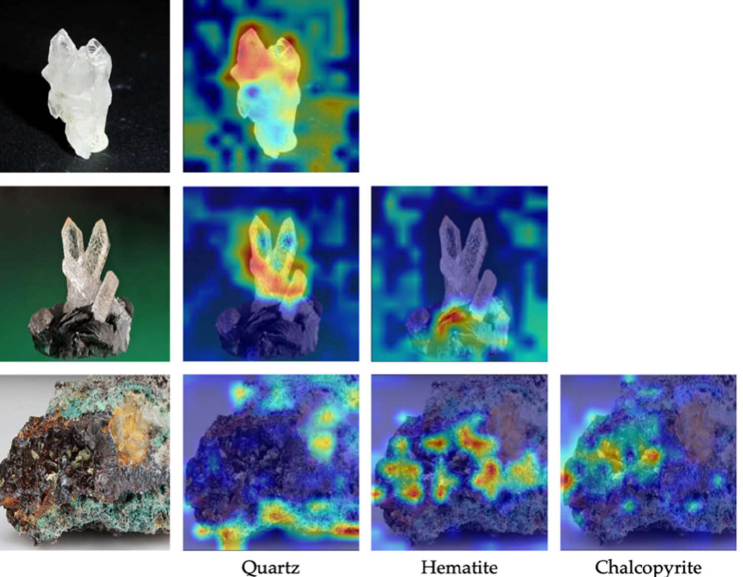
Figure 6. Class activation maps of three associated minerals based on Grad-CAM. The first column is the original mineral image, and the remaining columns are the Grad-CAM visualization results of a certain mineral.